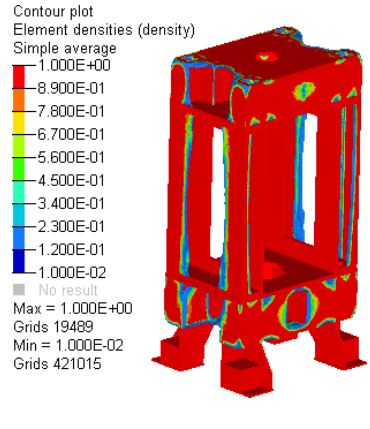
Figure 13. Optimized density diagram of macine frame.